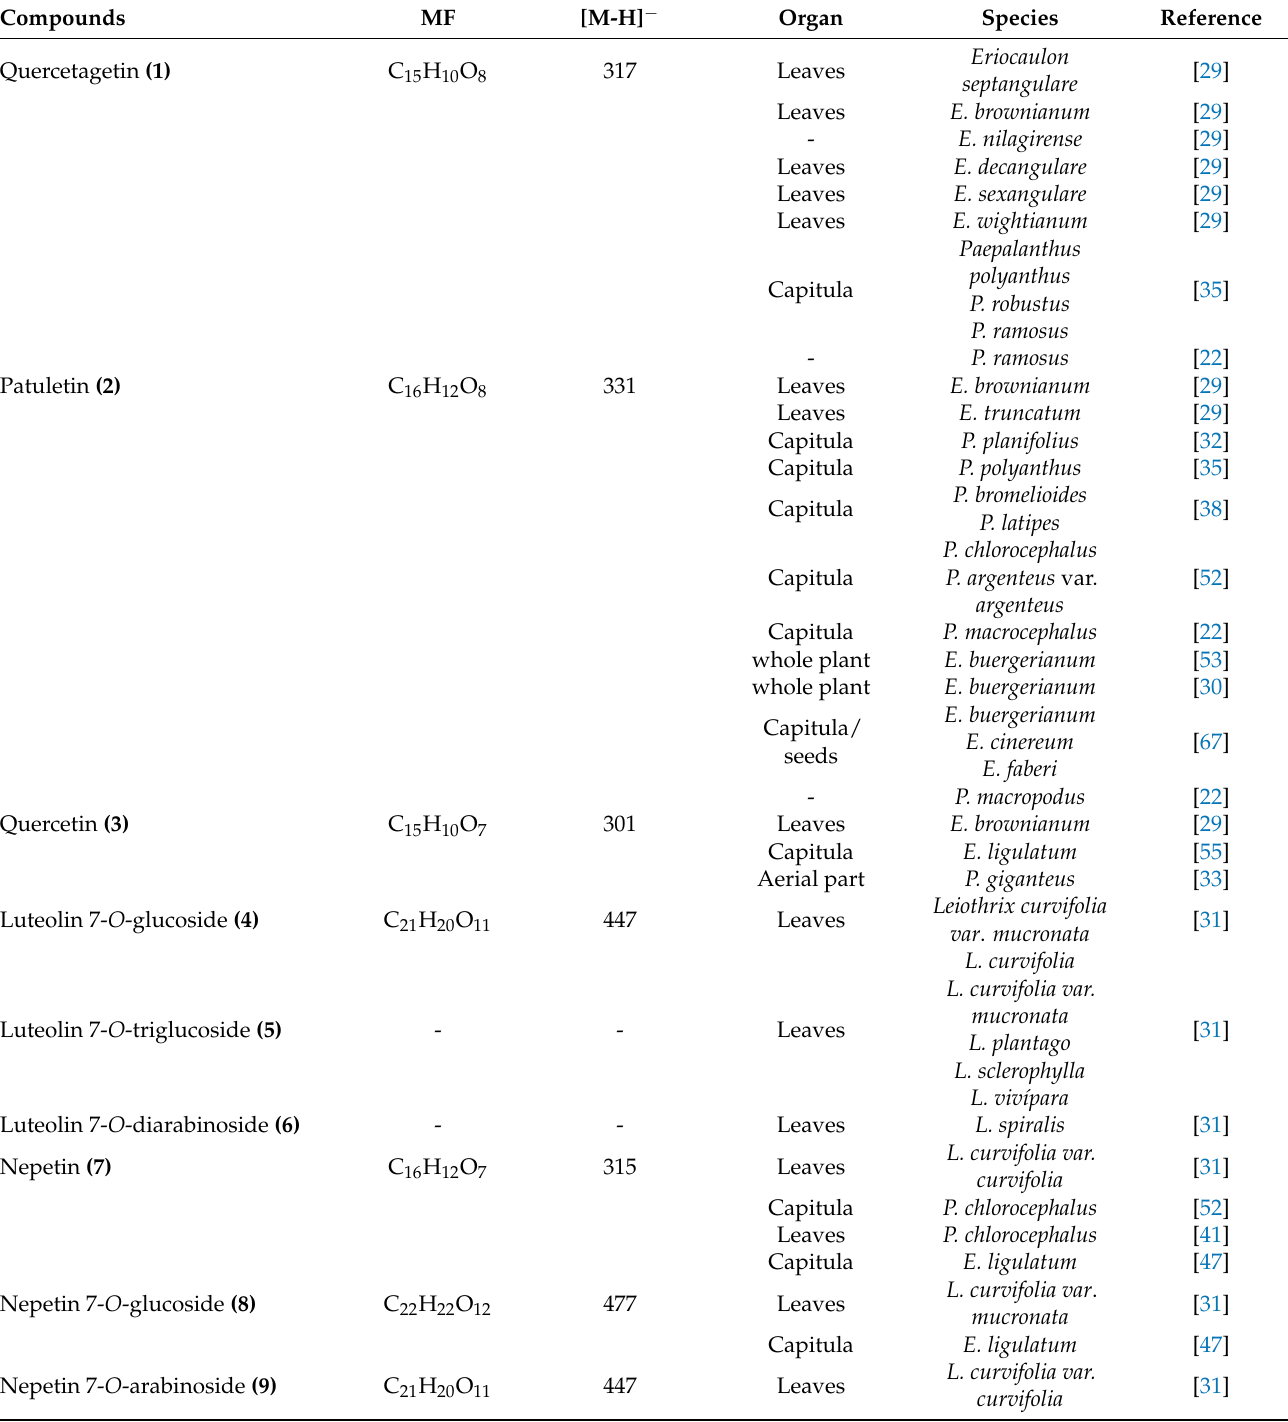
Table 1. Flavonoids isolated from Eriocaulaceae